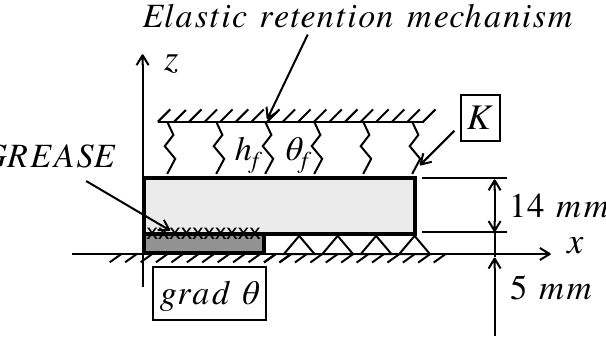
Figure 17. Model analyzed in this example where a thermal grease is introduced at the interface and the effect of different Winkler elastic support stiffness K and grad θ is analyzed.